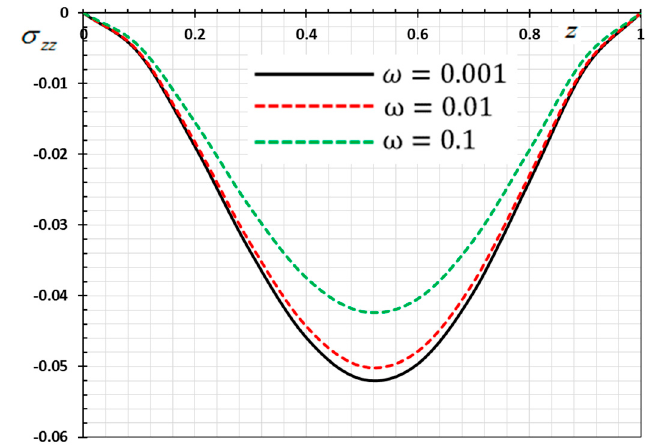
ff erent delay time ω . Materials 2020 , 13 , x FOR PEER REVIEW